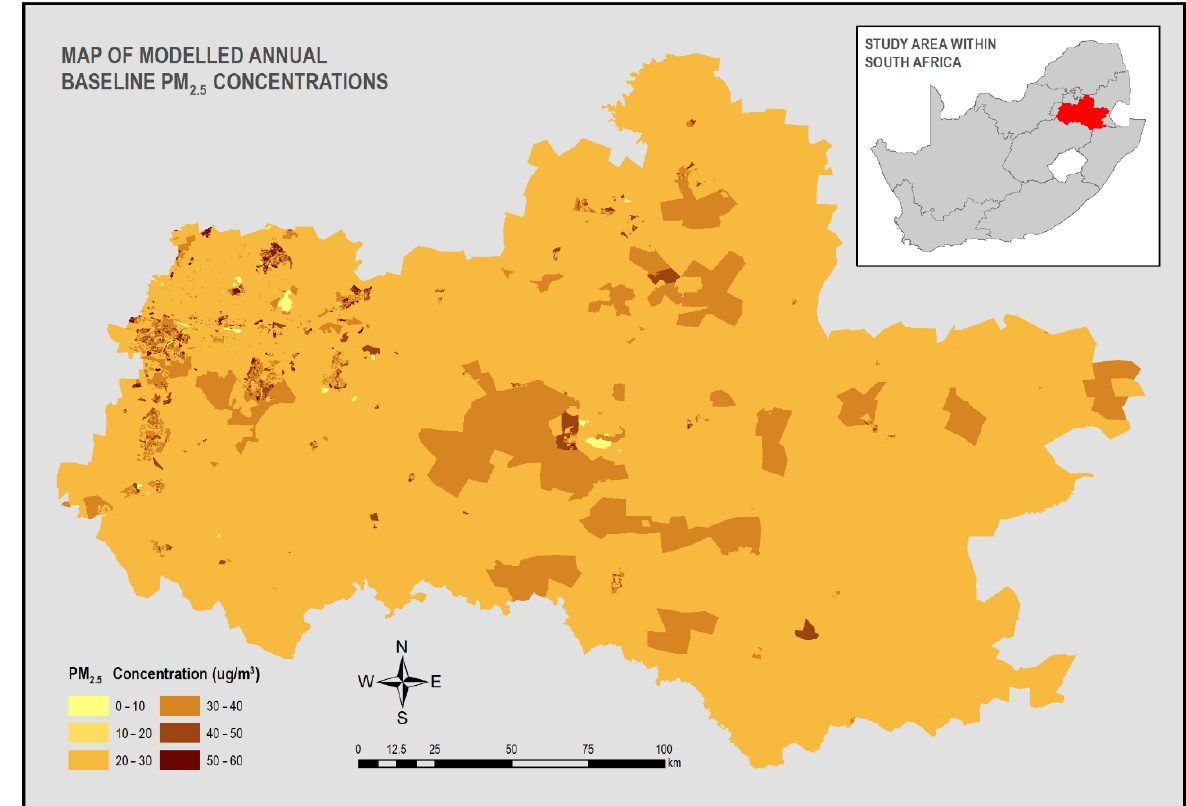
Figure 4. Map of modelled annual baseline PM 2.5 concentrations.